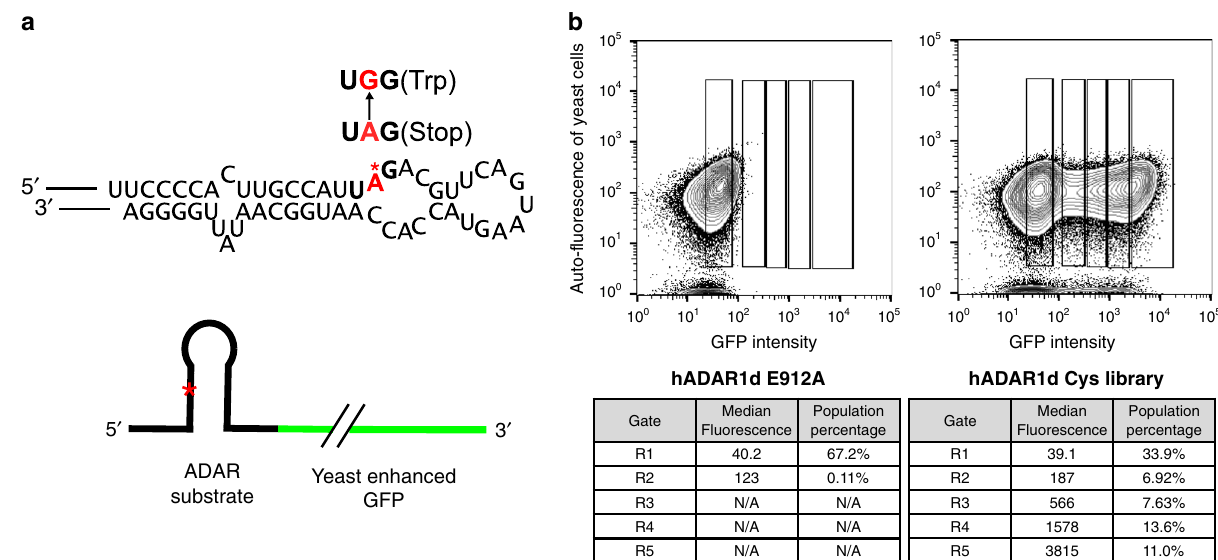
Fig. 1 Fluorescence-activated cell sorting of cysteine libraries of hADAR1d. a Schematic and ADAR substrate sequence of the fl uorescent reporter used in Sat-FACS-Seq analysis. Editing site A is shown in red. b Fluorescence-activated cell sorting for hADAR1d E912A (deaminase inactive mutant) and hADAR1d cysteine libraries. hADAR1d E912A was used to determine the background level of fl uorescence. Top: Cells expressing either yeGFP reporter and hADAR1d E912A or yeGFP reporter and hADAR1d Cysteine libraries were sorted into different gates based on the different levels of fl uorescence. Bottom: Parameters corresponding to each sorting